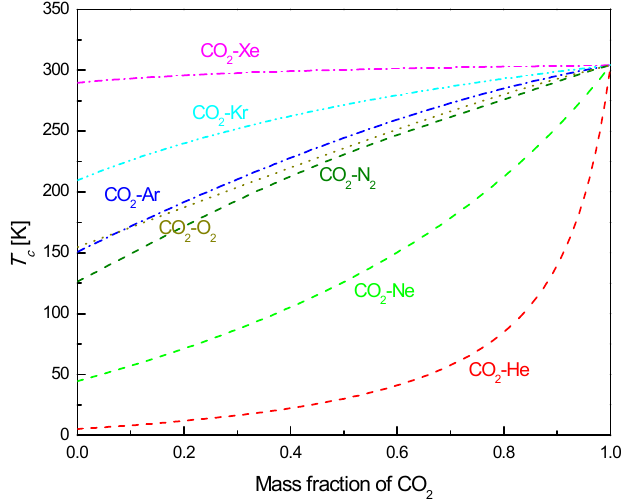
ff erent mass fractions of CO